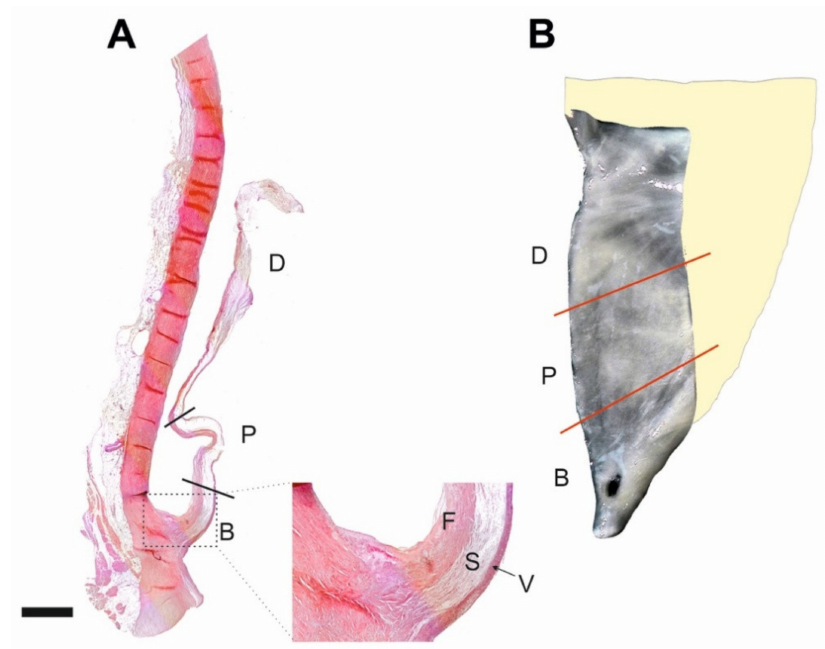
Figure 1. Normal morphology of the aortic valve. ( A ) Paramedian longitudinal section of a valve cusp spanning its basal–B, proximal–P, and distal–D parts. Higher magnification of the basal cusp part (inset) shows typical three-layered architecture: F–fibrosa, S–spongiosa, V–ventricularis. Hematoxylin and eosin staining. Scale bar = 2 mm. ( B ) Stereomicroscope image showing whole-mount specimen of the medial part of the bisected cusp with demarcation of its three parts (B, P, D) as in ( A